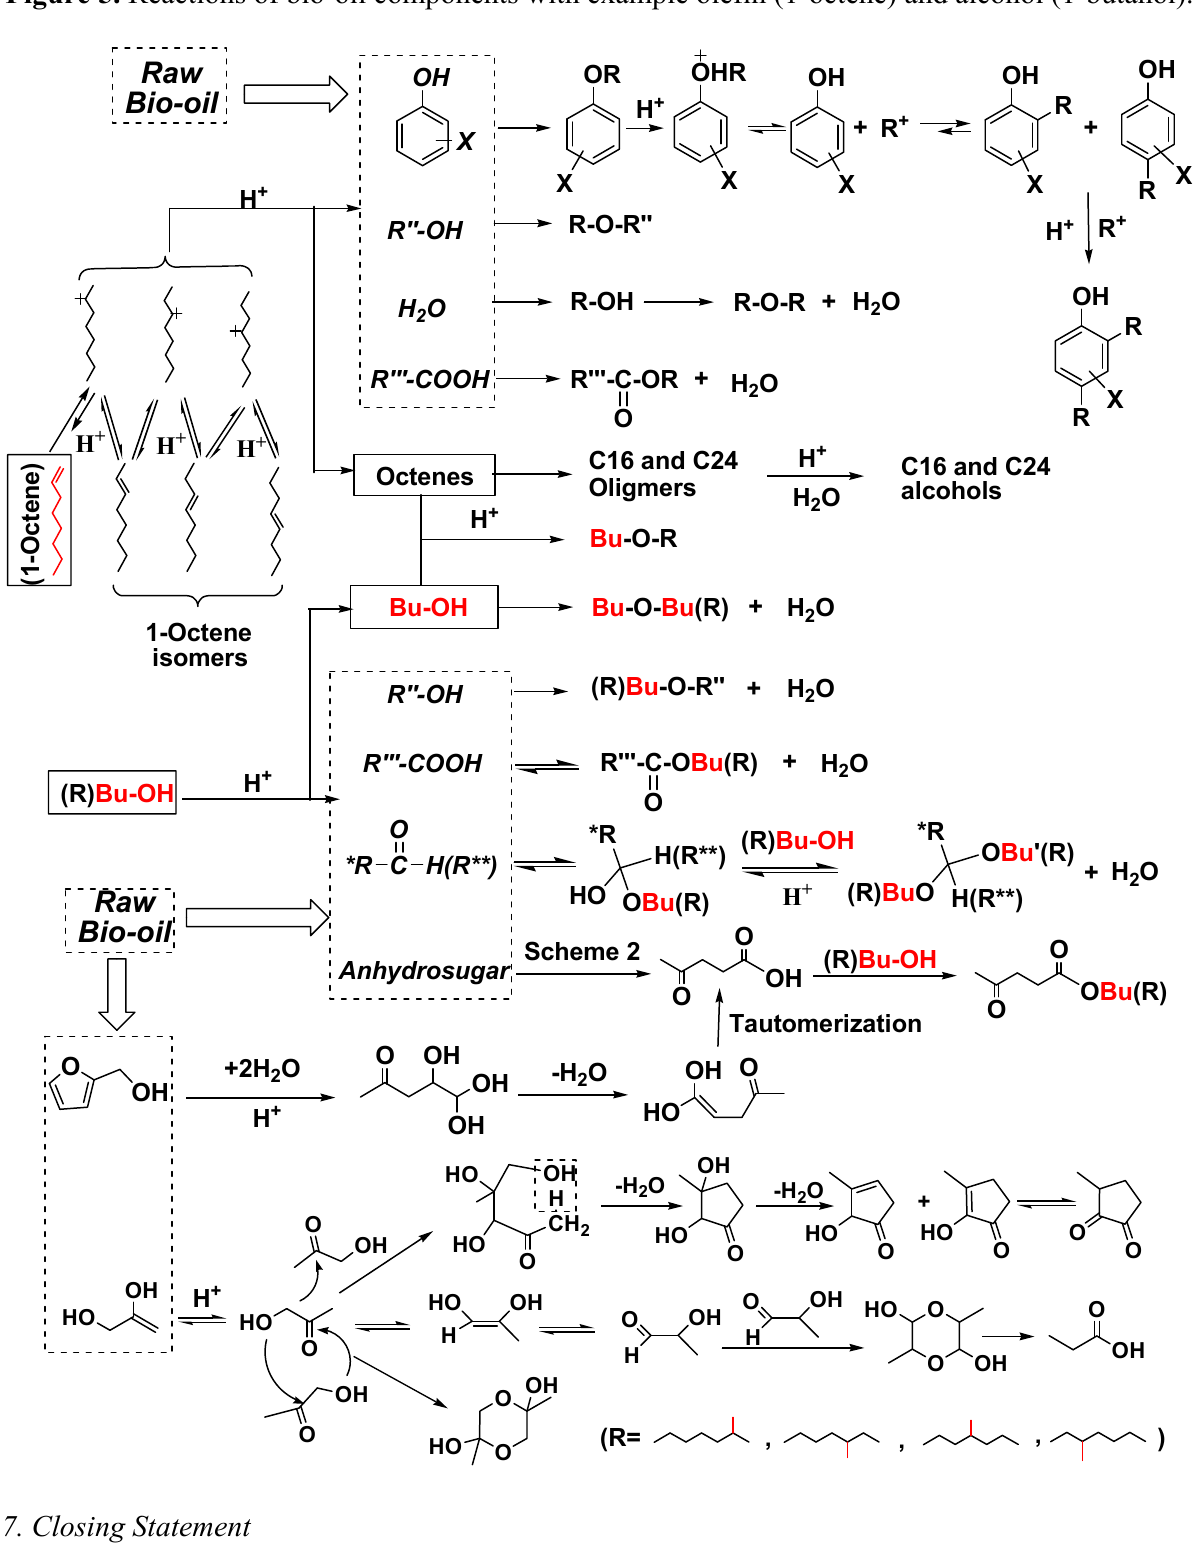
Figure 5. Reactions of bio-oil components with example olefin (1-octene) and alcohol